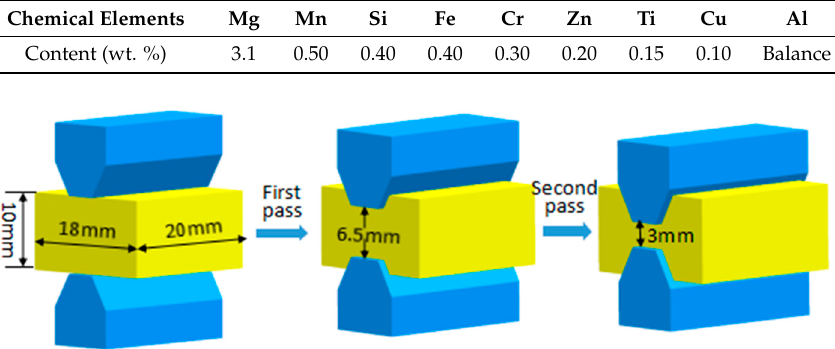
Figure 1. The shapes and sizes of the specimens used for hot compression testing.